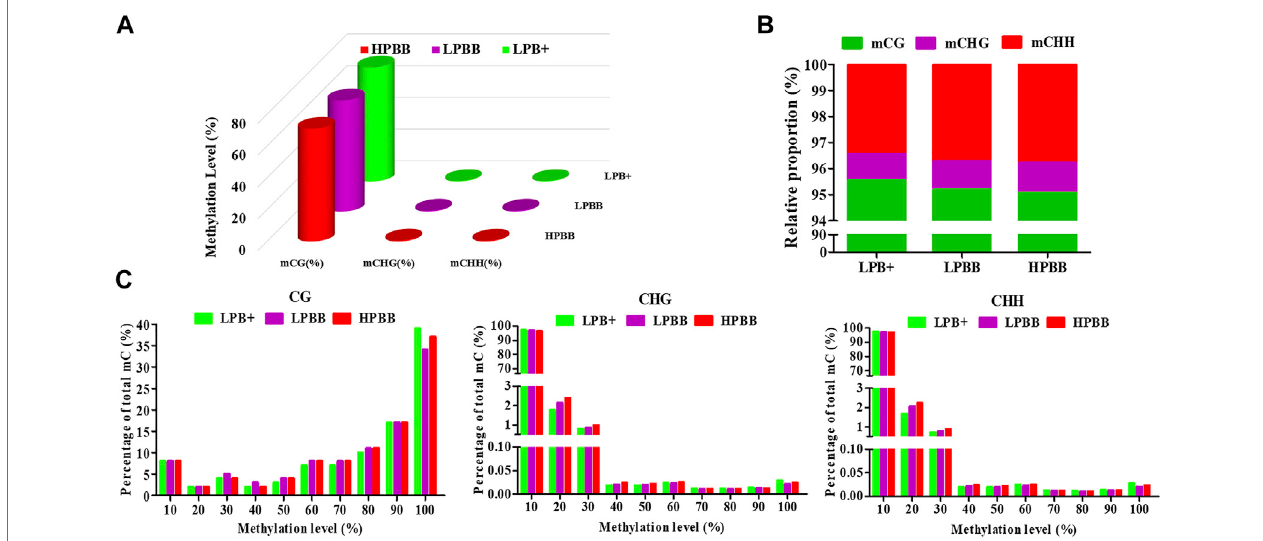
FIGURE 1 | DNA methylation levels and distribution in ovaries of Hu sheep with different proli fi cacies. (A) Genomic methylation levels of CG, CHG, and CHH in different groups. (B) Relative average proportions of CG, CHG, and CHH methylation contexts in ovaries among different groups. (C) The average methylation percentage (y-axis) for different methylation levels (x-axis) of CG, CHG, and CHH methylation in different